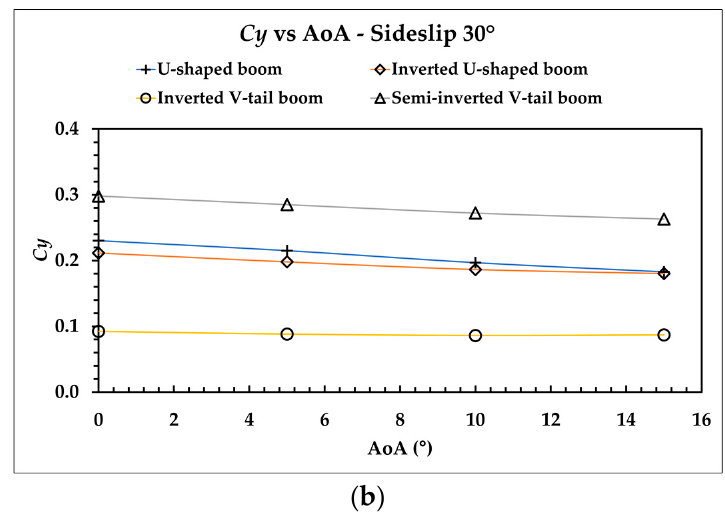
Figure 18. Cy vs. AoA, sideslip angle: ( a ) 15° and ( b ) 30°.